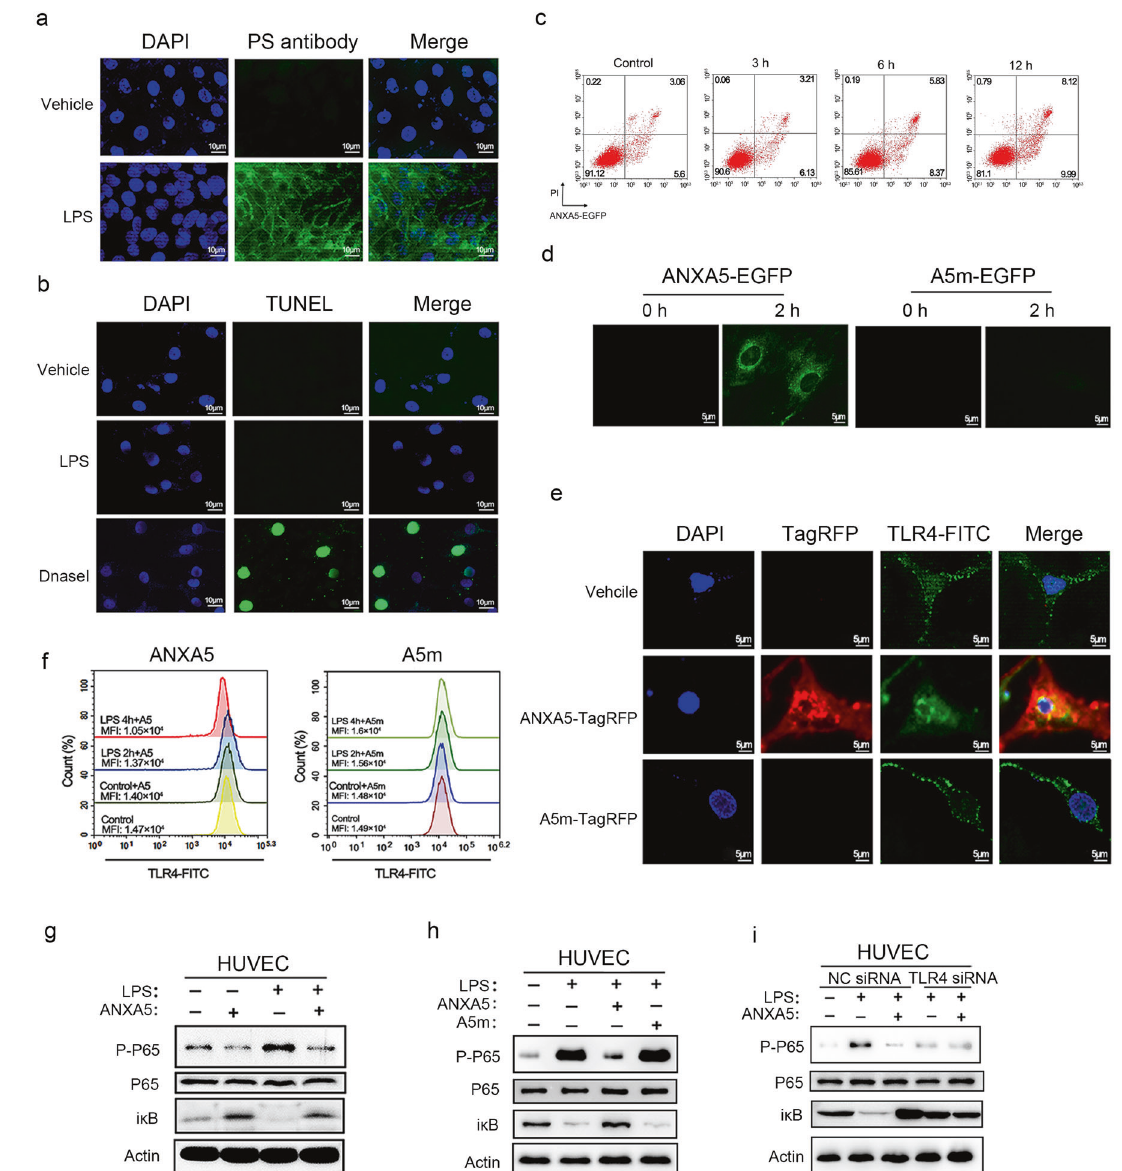
Fig. 7 ANXA5 induces the internalization of TLR4 via a PS-dependent entry. a PS externalization is present in LPS-activated HUVECs. Living HUVECs activated by LPS (1 μ g/ml) were incubated with anti-PS antibodies. Then HUVECs were stained by AF488-conjugated secondary antibody. No LPS treatment as a negative control. Scale bars: 10 μ m. b LPS-activated HUVECs were examined by TUNEL assay. Dnase I treatment as a positive control. c HUVECs were treated with LPS for different times. The exposed PS on activated HUVECs was detected by ANXA5-EGFP (50 μ g/ml) and analyzed by FACS analysis. d Direct fl uorescence observation of living HUVECs incubated with ANXA5/A5m-EGFP. After 2 h of ANXA5/A5m-EGFP incubation, HUVECs were observed by fl uorescence microscope. e LPS-activated HUVECs were activated by LPS and then incubated with TLR4-FITC antibody. In the absence of ANXA5-TagRFP, the fl uorescence signal of TLR4-FITC was spotty mainly on the plasma membrane. When the addition of ANXA5-TagRFP, TLR4-FITC was observed inside cells and co-localized with ANXA5-TagRFP. A5m- TagRFP as a negative control. f HUVECs were activated with LPS (1 μ g/ml) for 0, 2, 4 h, and then treated with ANXA5 (250 nM) or A5m (250 nM) for 30 min. The surface TLR4 was stained by TLR4-FITC antibody for FACS. Data are presented as mean value of MFI representative for three independent experiments. g The activation of NF- κ B in HUVECs treated with LPS and ANXA5 as indicated. P65 phosphorylation and I κ B degradation were analyzed by western blot. h HUVECs were treated with different stimulation as indicated and were analyzed by western blot with antibodies against p65 and i κ B. i HUVECs were transfected with NC siRNAs or TLR4 siRNAs. After stimulation with LPS and ANXA5, NF- κ B activation was analyzed by western blot